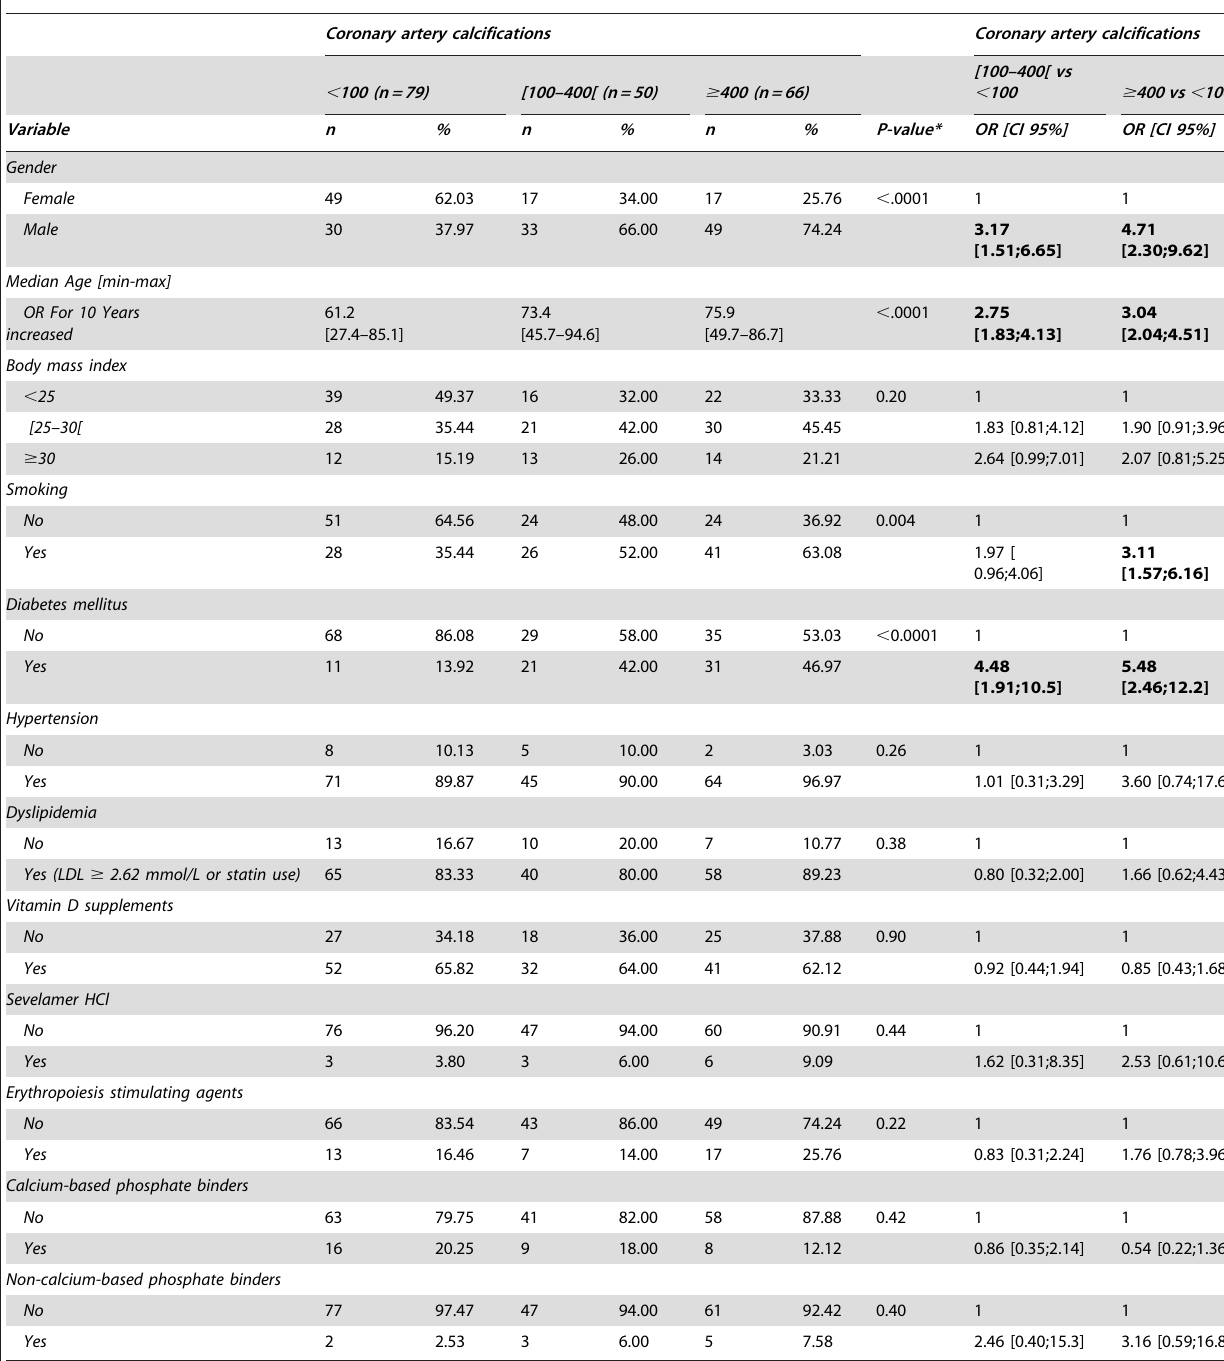
Table 2. Clinical markers associated to increased coronary artery